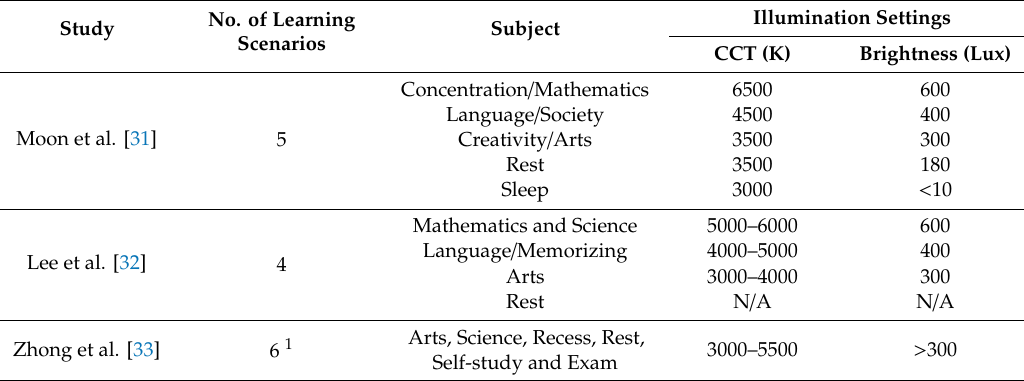
Table 2. Learning scenarios and lighting parameters of reference